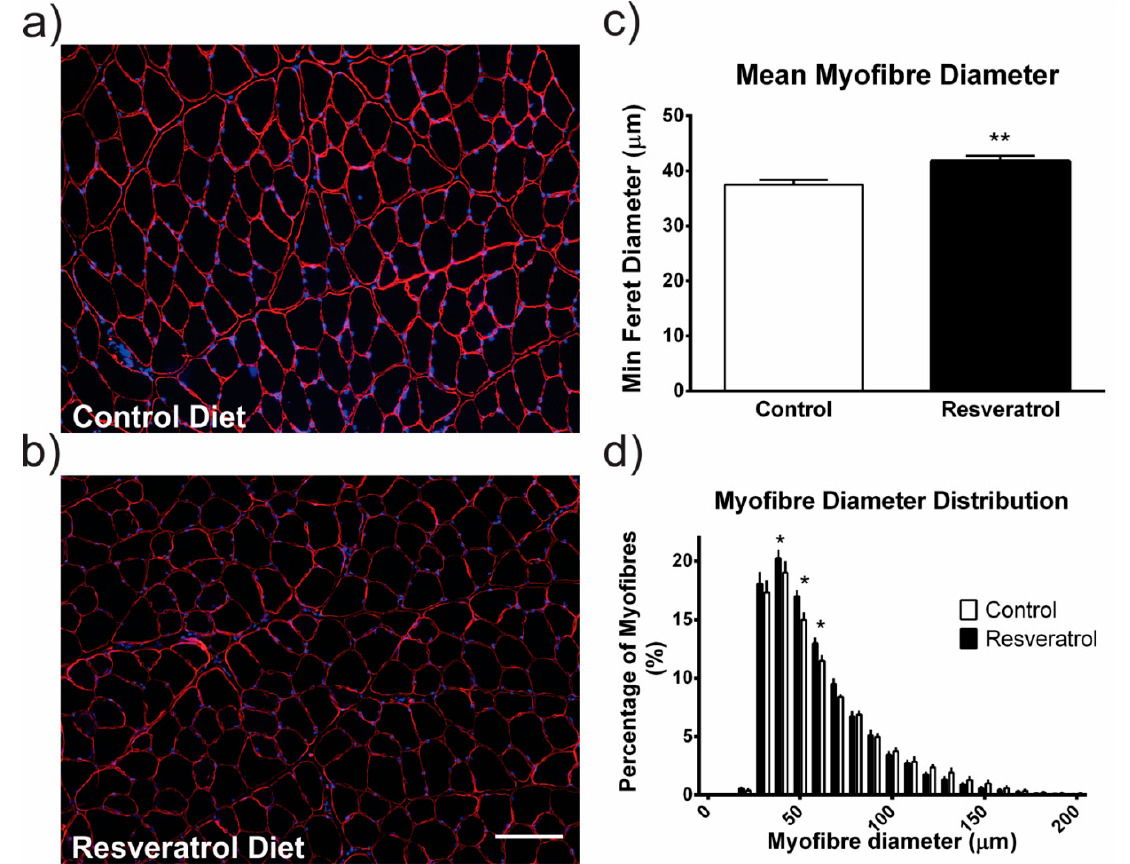
Figure 1. Frozen quadriceps sections were stained with laminin α 2 (red) which outlines the individual myofibres and Hoechst (blue) which stains the nuclei. ( a ) Representative image of a stained quadriceps from a mouse on the control diet. ( b ) Representative image of a resveratrol treated mouse quadriceps. ( c ) The average myofibre diameter within the quadriceps muscle is significantly larger in the resveratrol treated cohort in comparison to the control cohort. ( d ) The myofibres were grouped into 10 µ m intervals and the proportion of myofibres in each interval was plotted in a histogram. There were more myofibres measuring between 50 and 70 µ m in the resveratrol treated group in comparison to the control group. The white scale bar indicates 200 µ m. Graphs show mean ± SEM. * indicates p < 0.05, ** indicates p < 0.001. n = 5 for each treatment